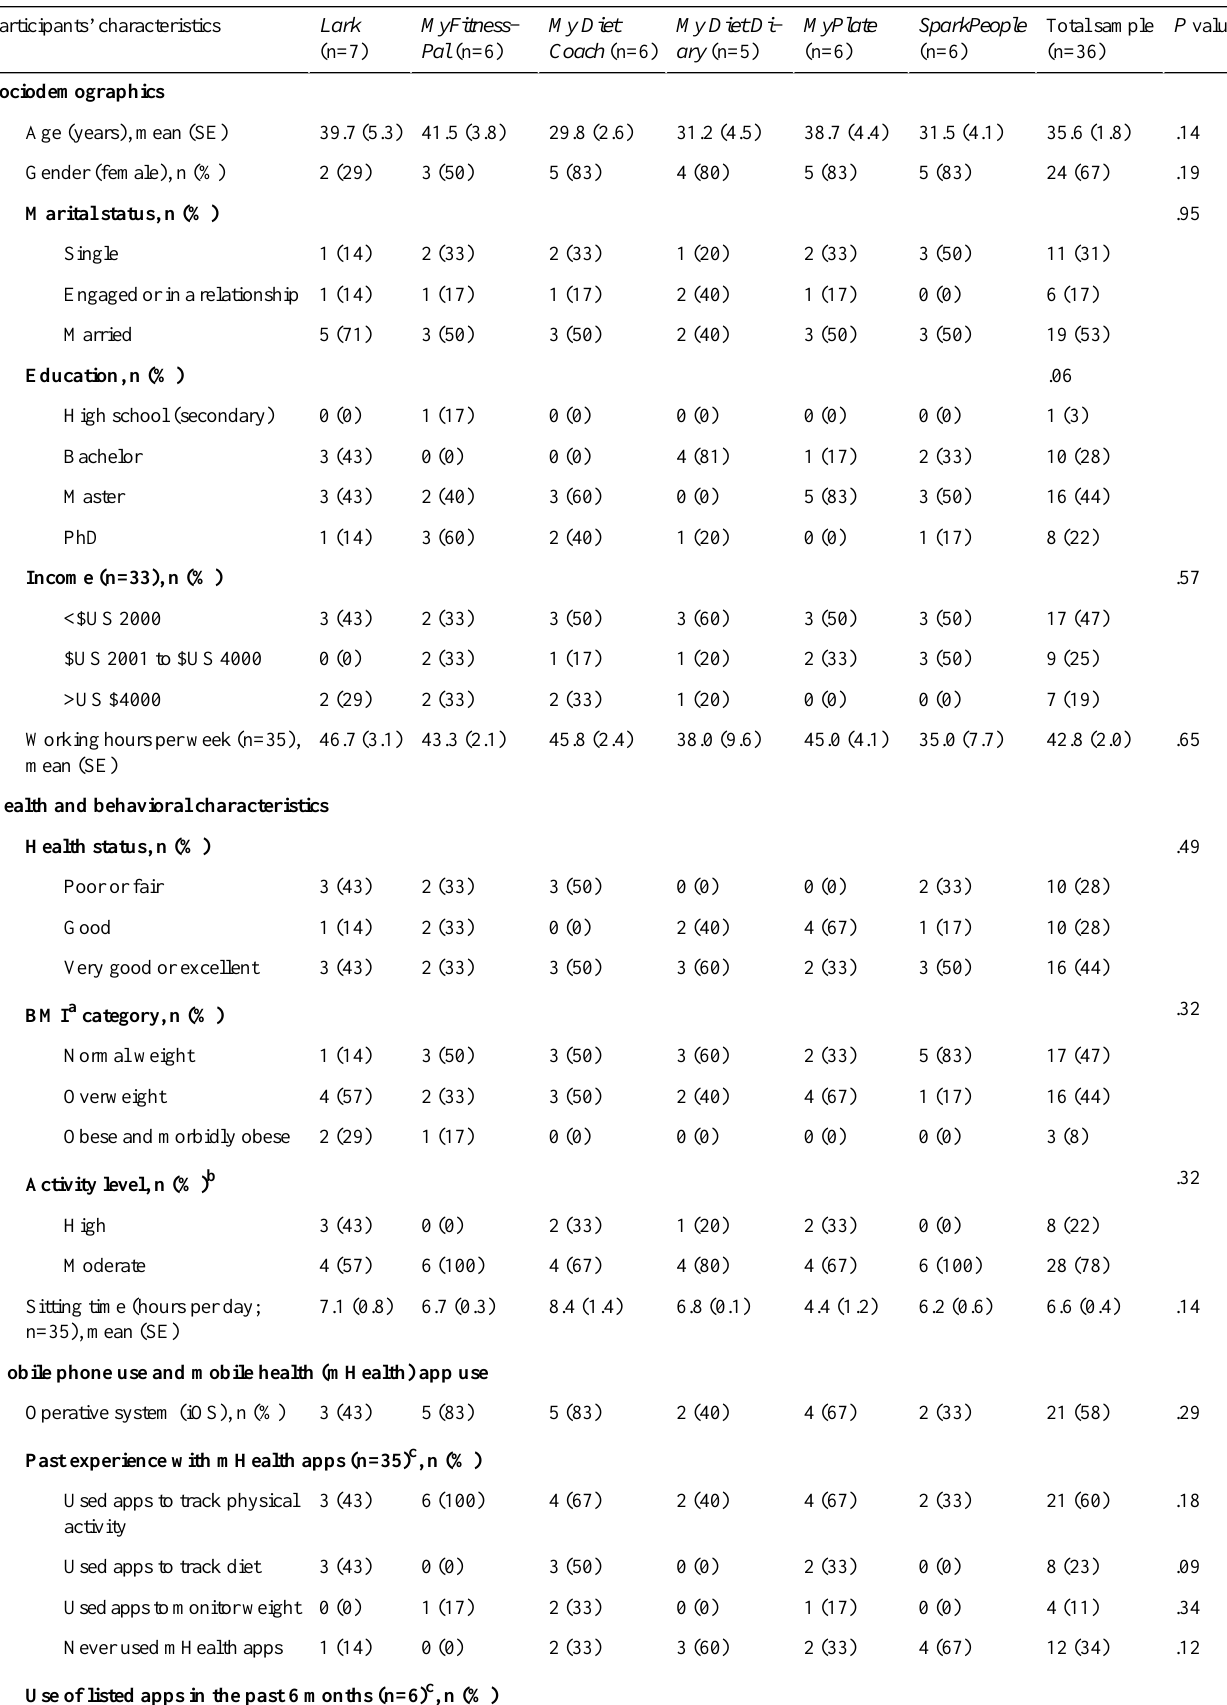
Table 2. Characteristics of study participants according to app group and total sample